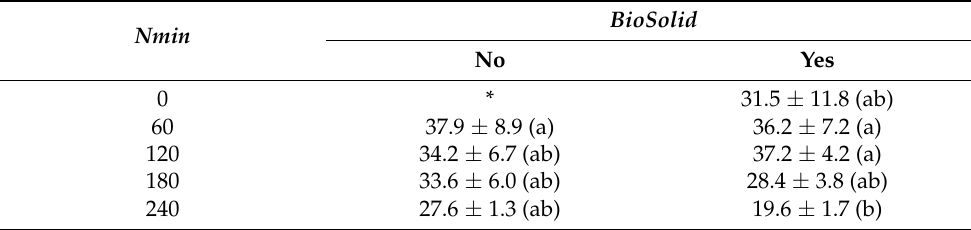
Table 3. Nitrogen agronomic efficiency (NAE) as a function of fertiliser treatment. The table shows the mean value ± standard deviation of each BioSolid and Nmin combination. Treatments with the same letter are not significantly different ( α = 0.5).